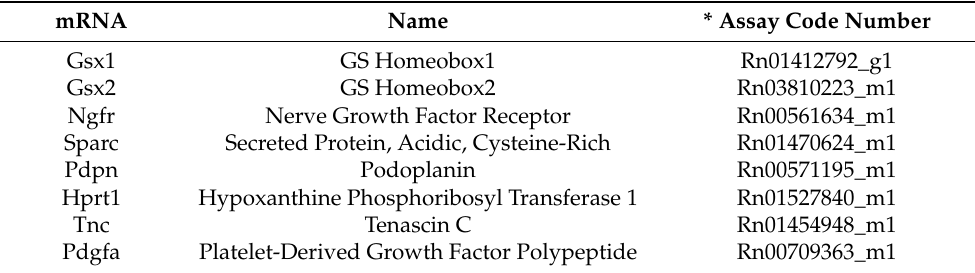
Table 1. TaqMan probes used for RT-qPCR